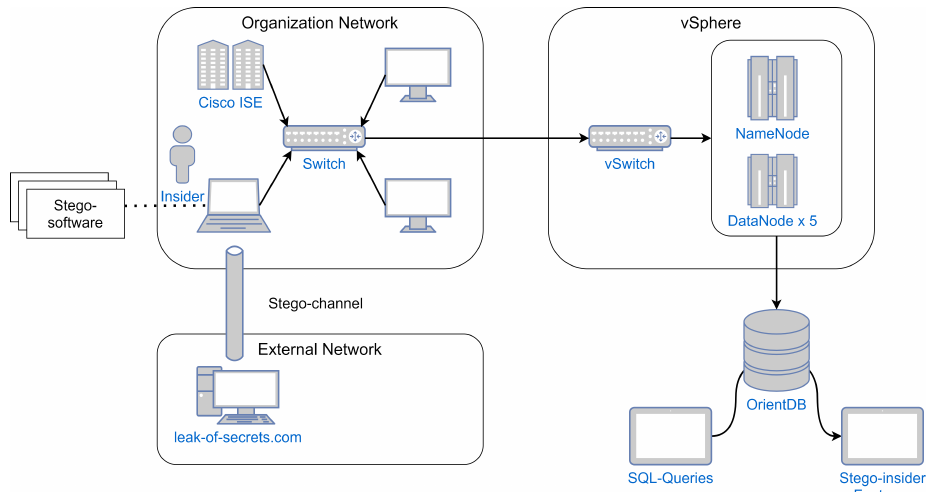
Figure 5. General scheme of experiment for determining the